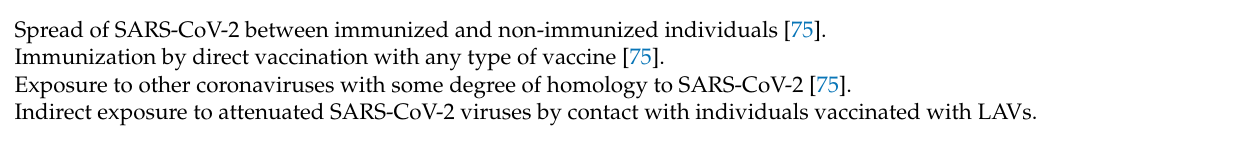
Table 1. Pathways that contribute to HI against the SARS-CoV-2 coronavirus.